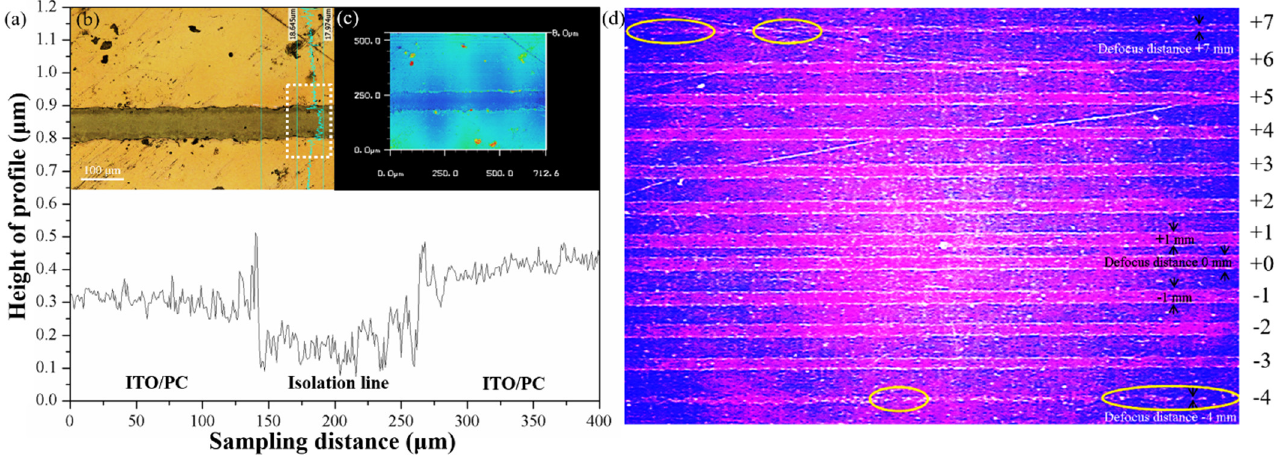
Figure 2. ( a ) Height profile of the isolation line. ( b ) Top view and ( c ) topography image of the ITO/PC with an isolation line. ( d ) The image of the isolation lines abraded by laser with defocusing distance from − 4 to +7 mm.